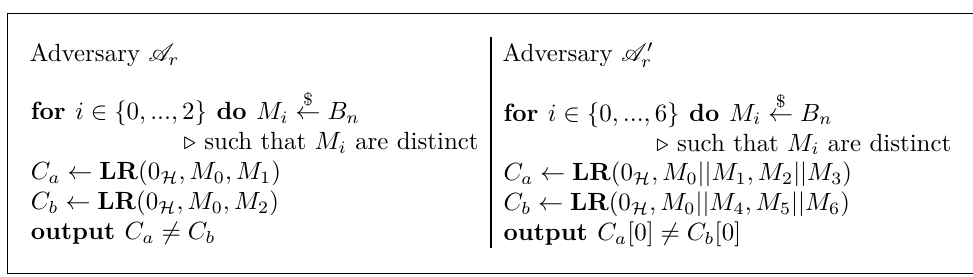
Figure 4: Header-repeating adversaries against blockwise left-or-right